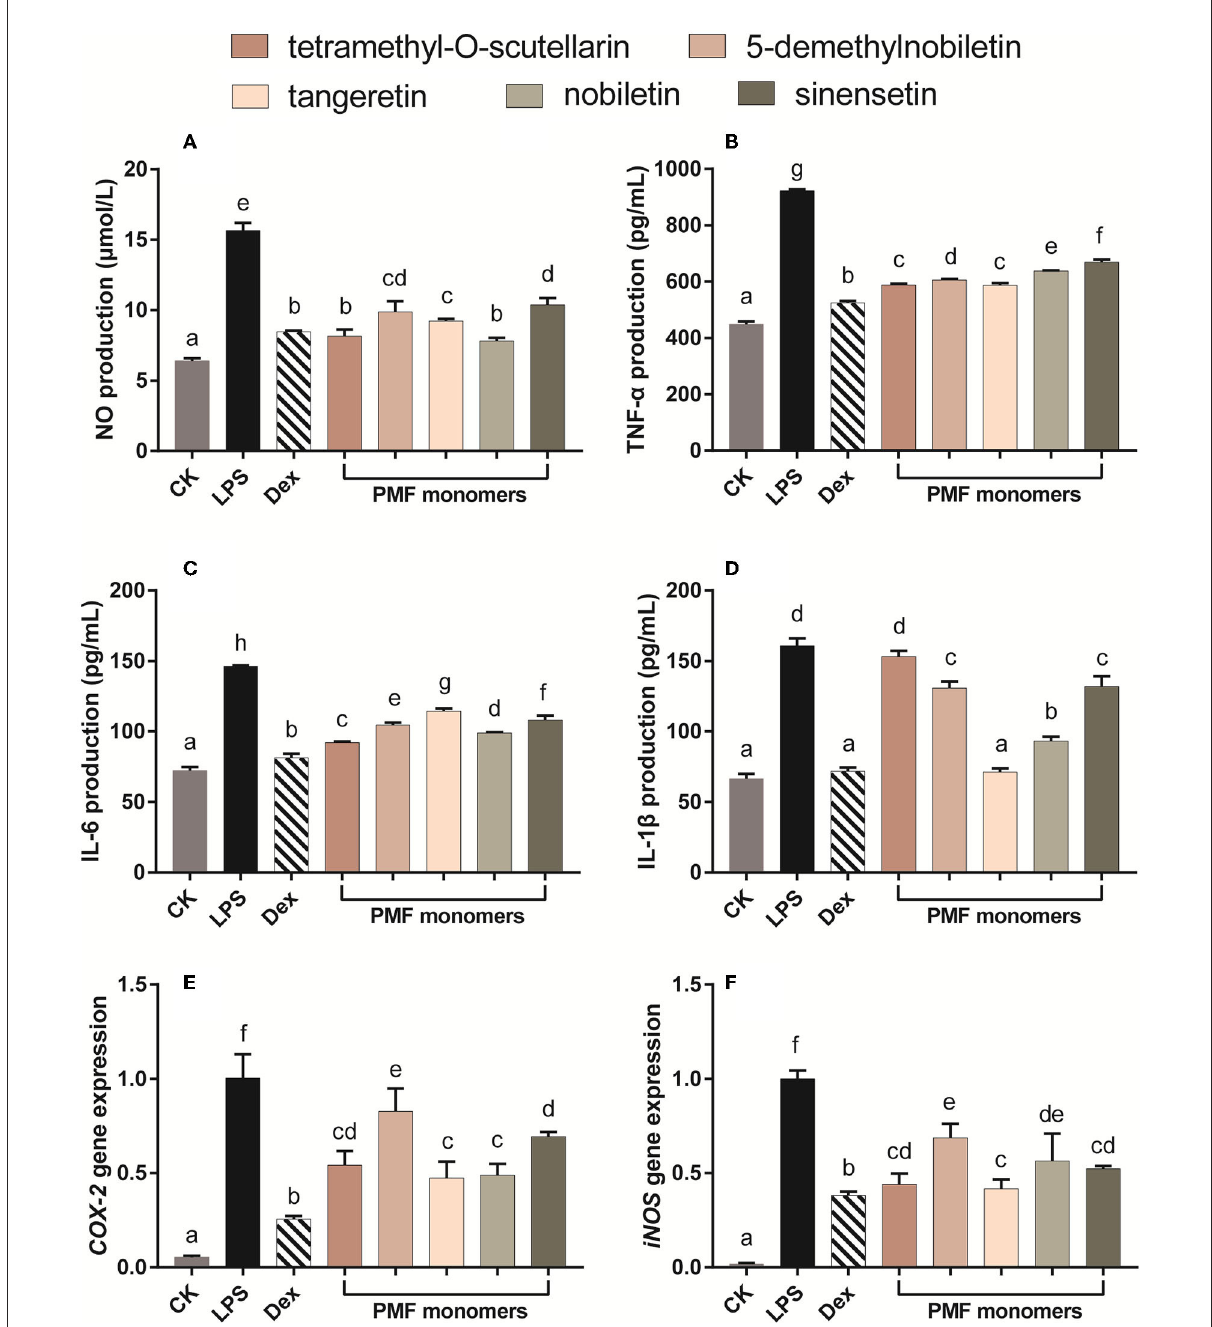
FIGURE3 Effects of different PMFs on NO production (A) , pro-inflammatory cytokine and gene expression profiles associated with chronic inflammatory (B,C) and acute inflammatory response (D–F) in the LPS-stimulated RAW264.7 macrophage cells. Results are expressed as means ± SD, n = 3 experiments. Means not sharing the same letter were significantly different (One-way ANOVA, Dunnett’s post-hoc test, p < 0.05 was considered significant).